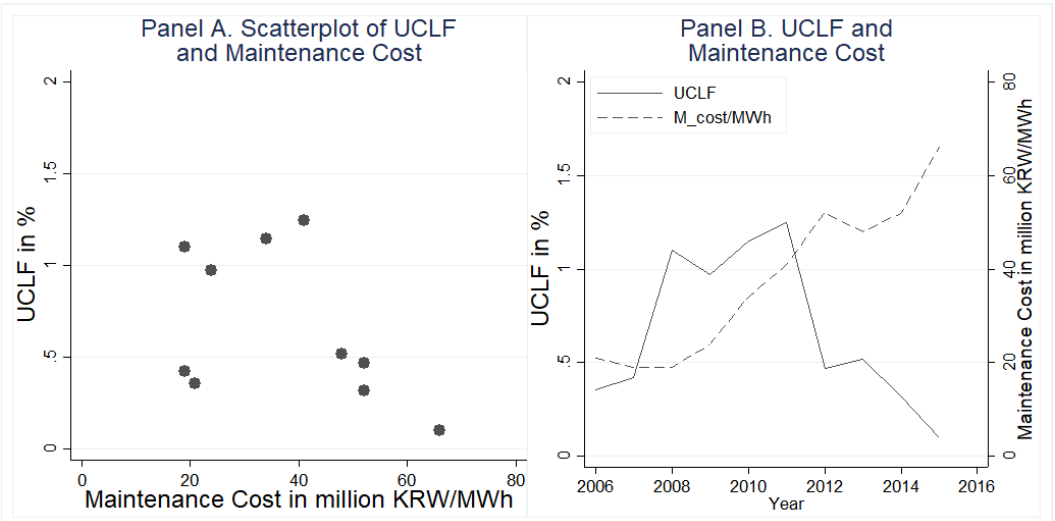
Figure 1. Unplanned capacity loss factor and maintenance cost. Note: UCLF = Unplanned capability loss factor (ratio of unplanned energy losses during a given period of time to the reference electricity generation); Million KRW is roughly 1000